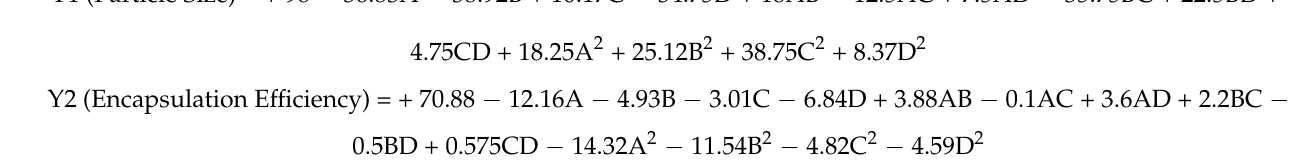
Table 1. Response surface methodology experimental design for CPDNL preparation.